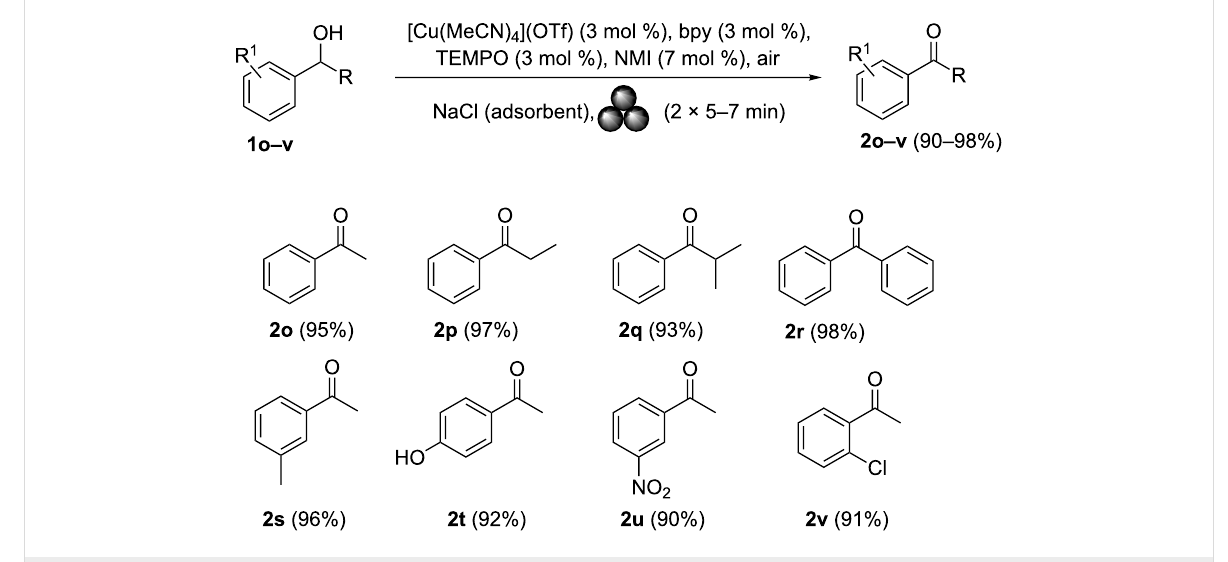
Scheme 4: Scope of secondary alcohols in oxidation under ambient